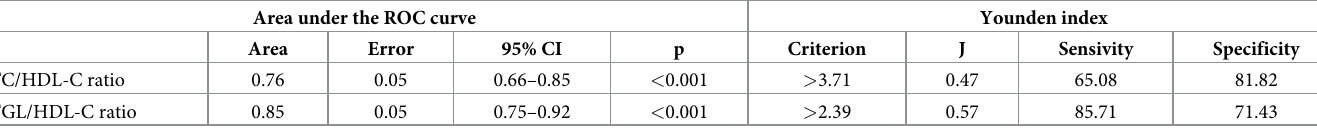
Table 2. AUCROC and cutoff values of TGL/HDL-C and TC/HDL-C ratios to estimate probability of metabolic syndrome in obese and overweight children.